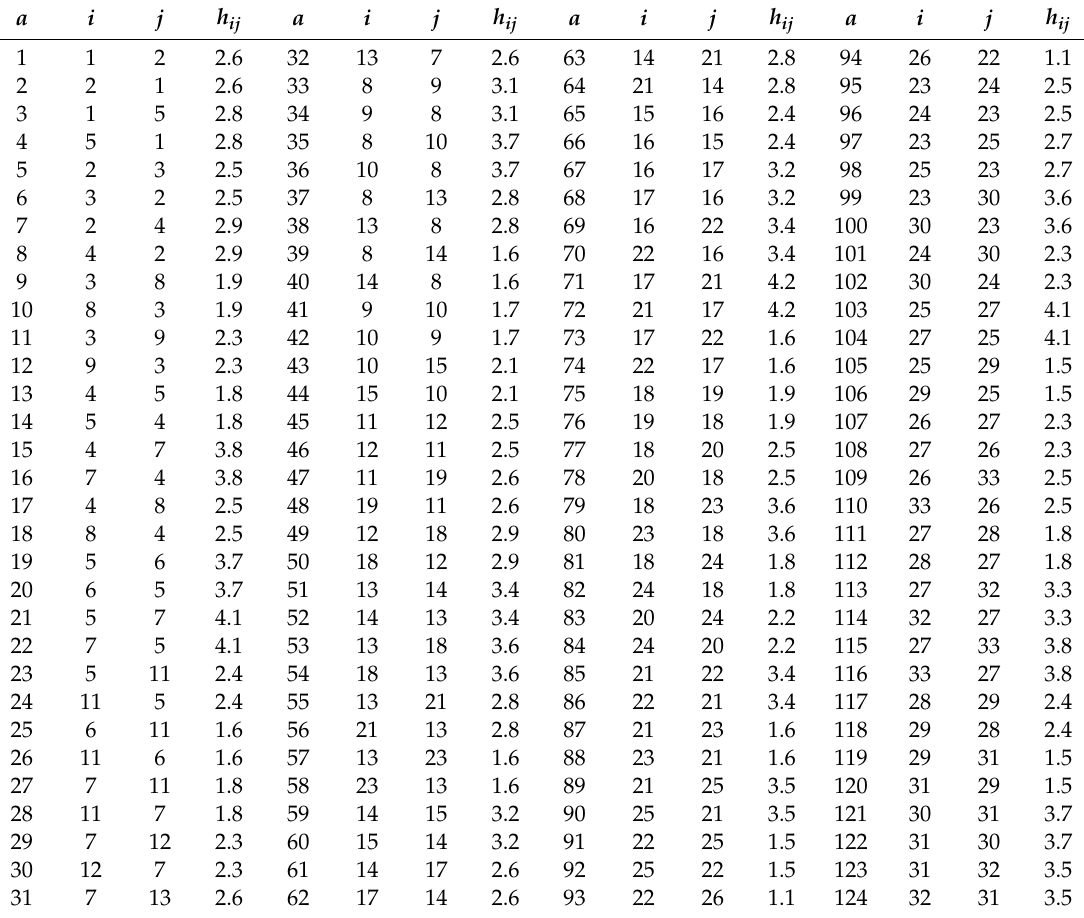
Table 1. Characteristics of all